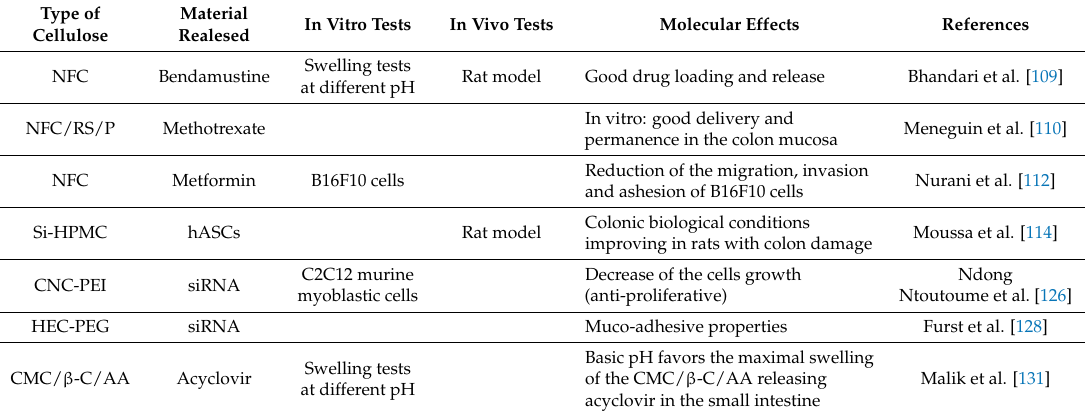
Table 6. Summary of the nano cellulose-based materials tested in “other